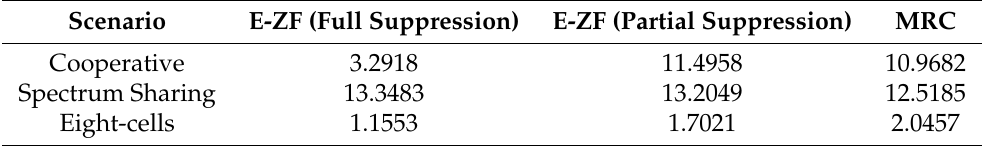
Table 4. Standard deviation values for the capacity per